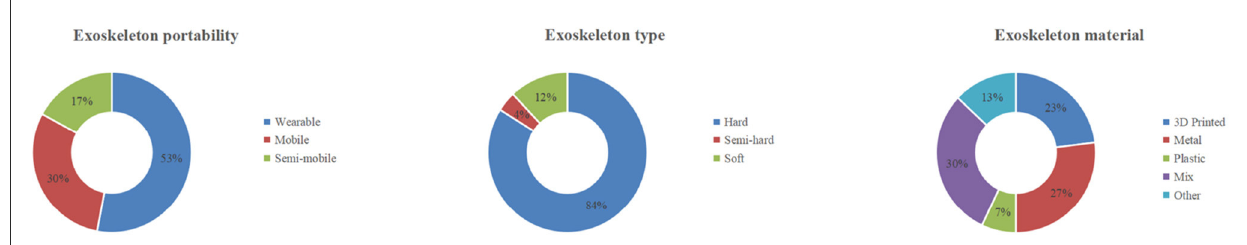
FIGURE2 The distribution of physical properties of the upper exoskeletons in terms of portability, exoskeleton type, and structural material (Vélez-Guerrero et al., 2021).